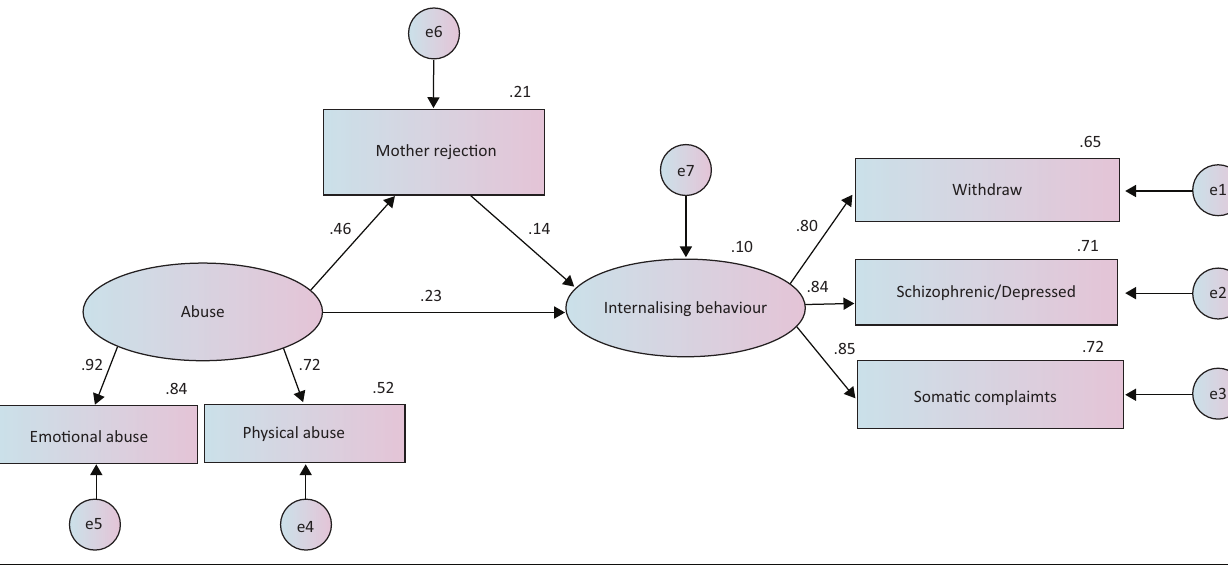
FIGURE 2: The partial mediation model in male sample ( n = 1305). TABLE 5: Comparisons among pathways from maltreatment to perceived rejection and internalising behaviour, using various measures of model fit.